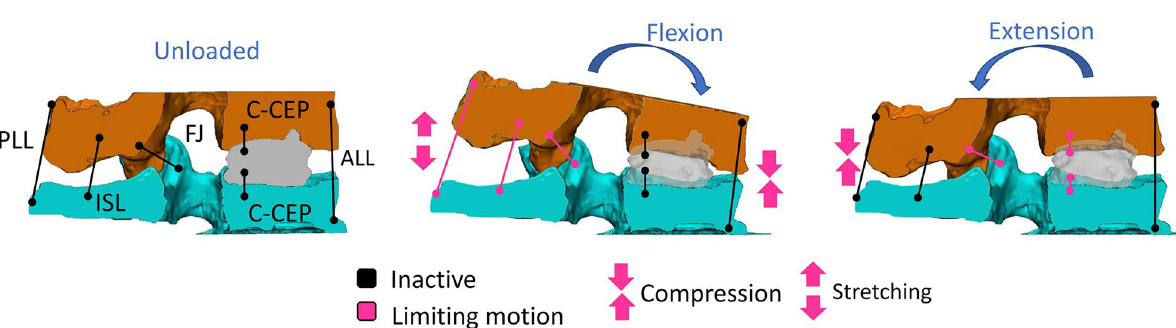
Figure 8. Influence of the cement mass (grey) in the specimen’s kinematics in flexion and extension. The main components (ligaments, contact surfaces, joints) are shown inactive (black) or active (pink) when they limit the motion, depending on the tested configuration. ALL: Anterior Longitudinal Ligaments, FJ: Facet Joints, ISL: Interspinous Ligament, C-CEP: Cement-Cartilaginous Endplate